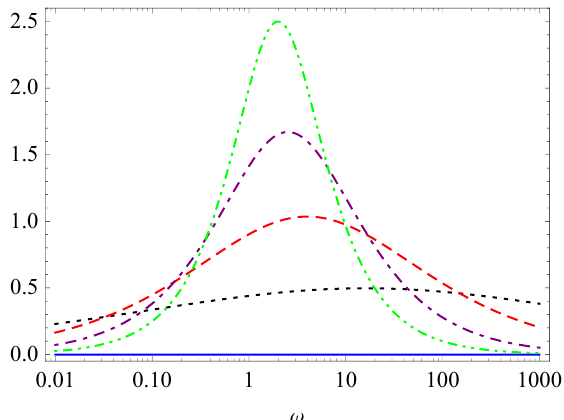
Figure 3. Curves of G s ∼ ω for a = 0.5, b 0 = 1, and b 1 = 3 and for α = 0 (solid line), 0.25 (dotted line), 0.5 (dashed line), 0.75 (dotted–dashed line), and 1 (dotted–dotted–dashed line) in the fractional Zener model (48).